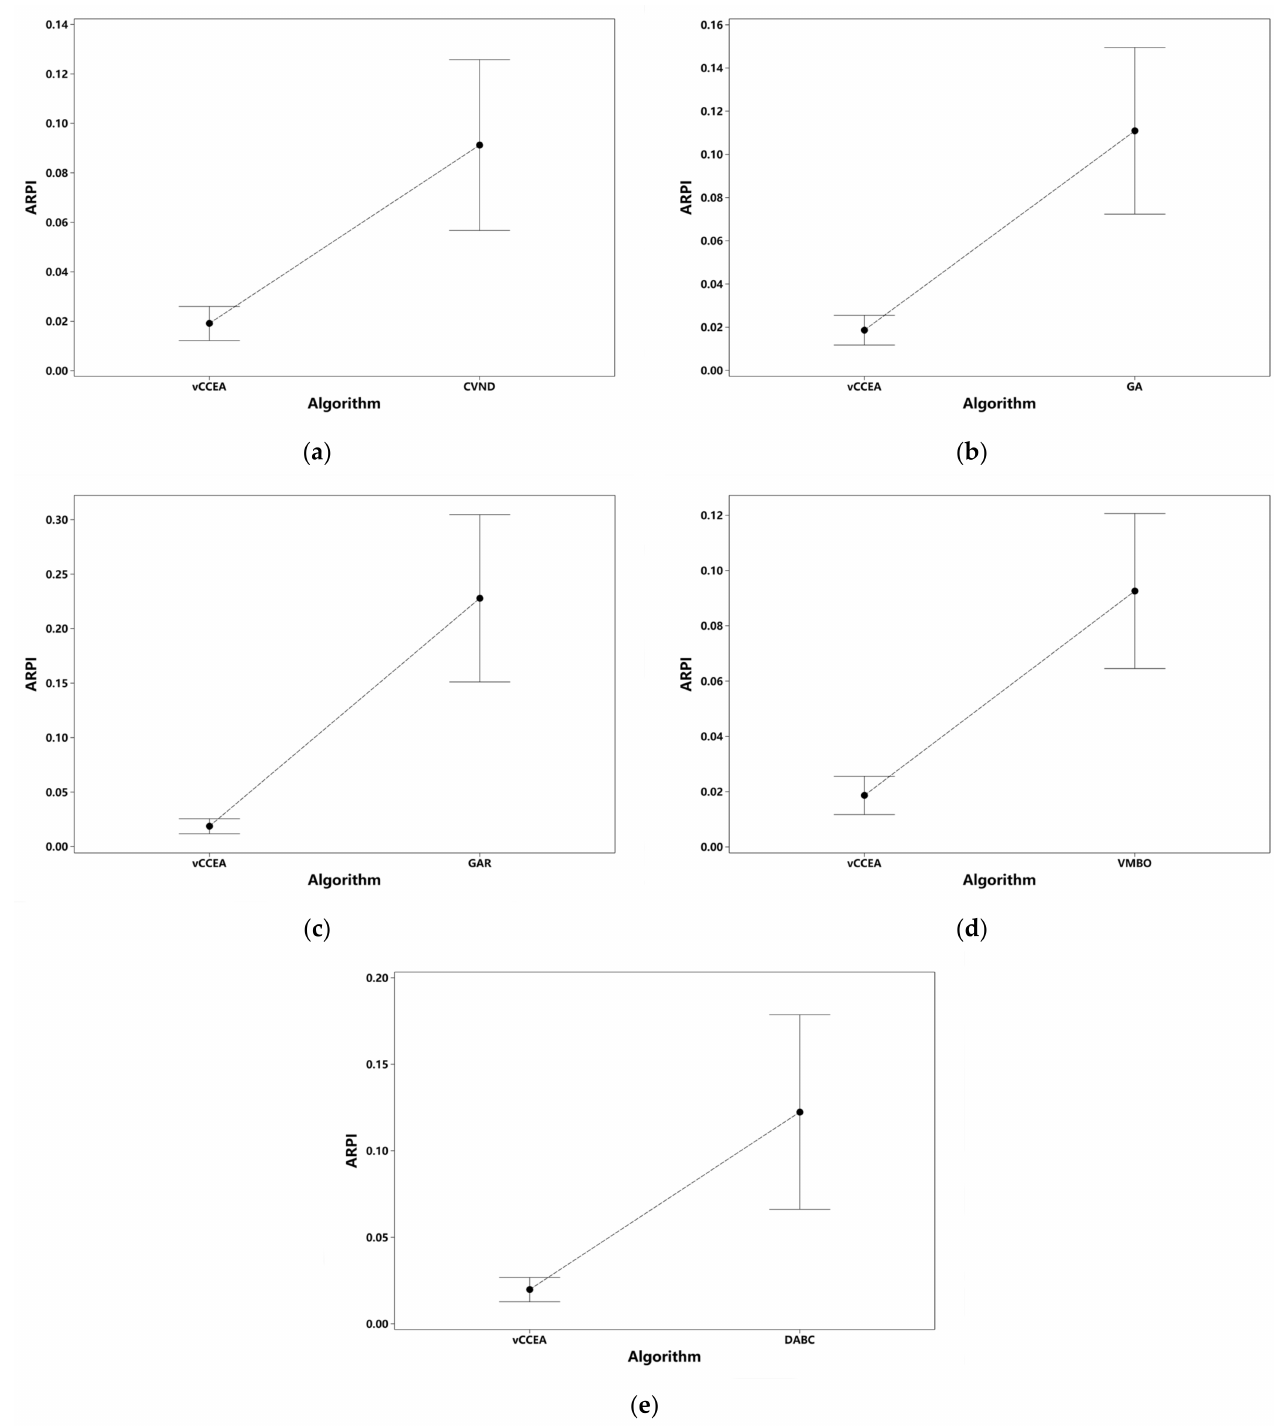
Figure 8. Confidence interval graph. ( a ) Confidence intervals of vCCEA and CVND; ( b ) confidence intervals of vCCEA and GA; ( c ) confidence intervals of vCCEA and GAR; ( d ) confidence intervals of vCCEA and VMBO; ( e ) confidence intervals of vCCEA and